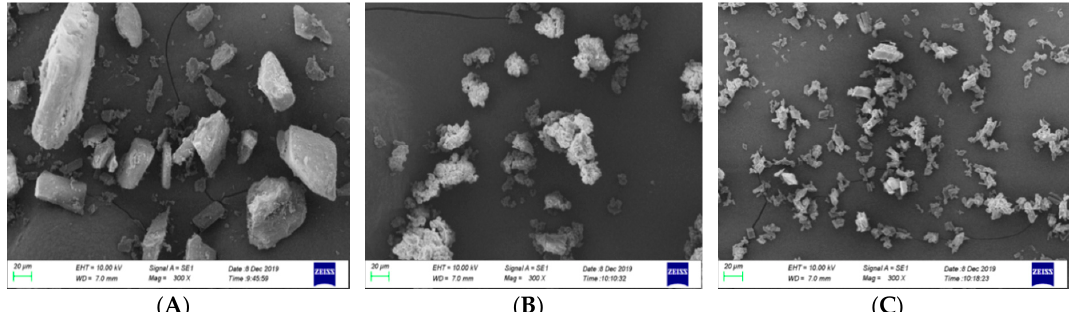
Figure 7. Scanning electron microscope images of β -CD ( A ), the physical mixture ( B ), and the LCEO/ β -CD inclusion complex ( C ) at 300× magnification.